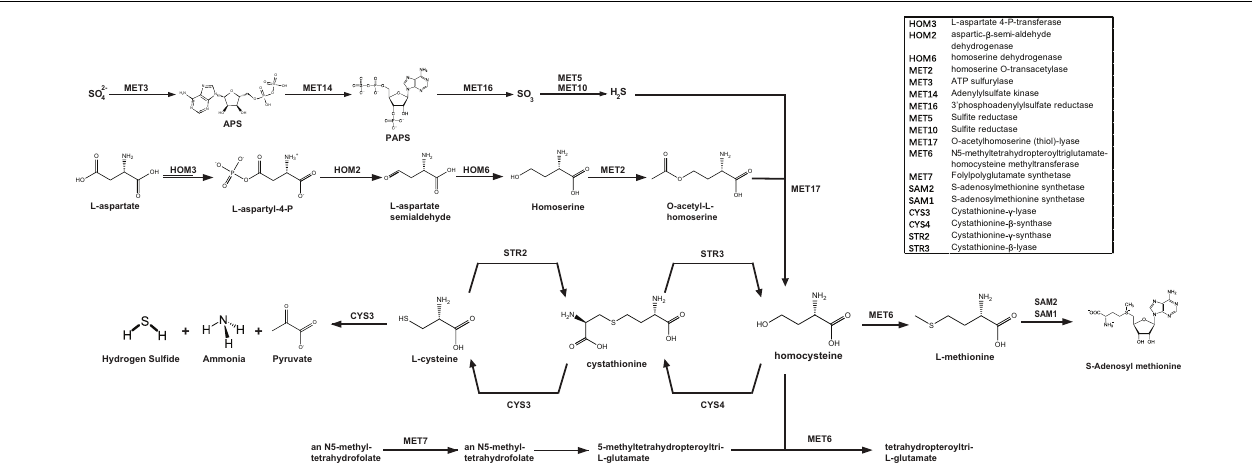
FIGURE 4 | “Sulfur amino acid biosynthesis superpathway” of S. cerevisiae . The re-organized sulfur amino acid biosynthesis superpathway of S. cerevisiae illustrates the sulfur metabolism in the yeast cells. The inorganic sulfur is initially metabolized in the sub-branch pathway by MET3 and the subsequent enzyme genes ( MET14 , MET16 , MET5 , and MET10 ) and then generate H 2 S, which will be synthesized to be homocysteine synthesized from the non-sulfur L -aspartate in the sub-branch pathway by HOM3 and the downstream enzyme genes ( HOM2 , HOM6 , MET2 , and MET17 ). For the sub-branch pathway begun with MET7 , the structure of the initial substrate, an N 5 -methyl-tetrahydrofolate, is far from the one of SPRC, and this sub-branch generate no H 2 S. Whereas the substrates in the sub-branch pathway ( CYS3 , CYS4 , STR2 , and STR3 ) are all sulfur-amino-acids and are structurally similar to SPRC, and also whereas CYS3 is capable to catalyze L -cysteine to generate H 2 S, this sub-branch is expected to be the metabolism pathway to SPRC and CYS3 is selected to be the catabolic enzyme candidate to SPRC for the consequent assays. which was accompanied by the phenotype of enhanced growth rate in the